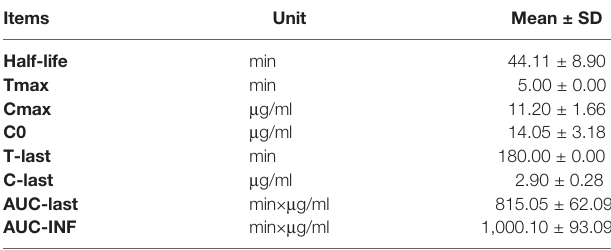
TABLE 1 | Pharmacokinetics of BPA in rats.